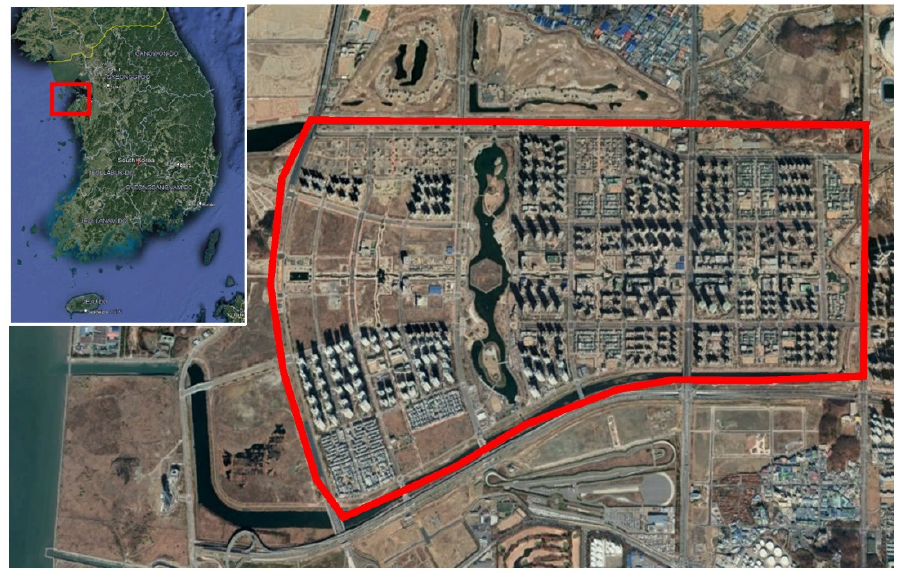
Figure 1. Location of Cheongna International City, Republic of Korea.